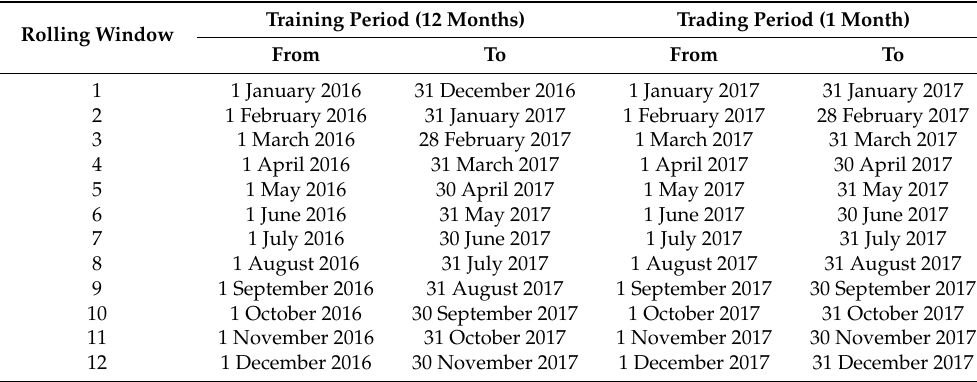
Table 5. The starting and end dates of each (in-sample) training period and (out-of-sample) trading period for each composed